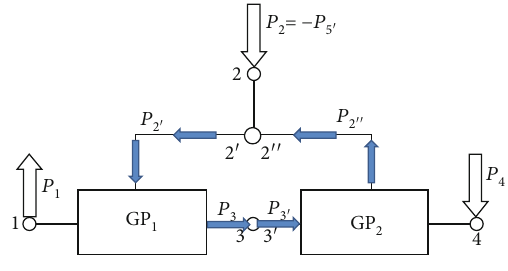
Figure 6: Power fl ow through the